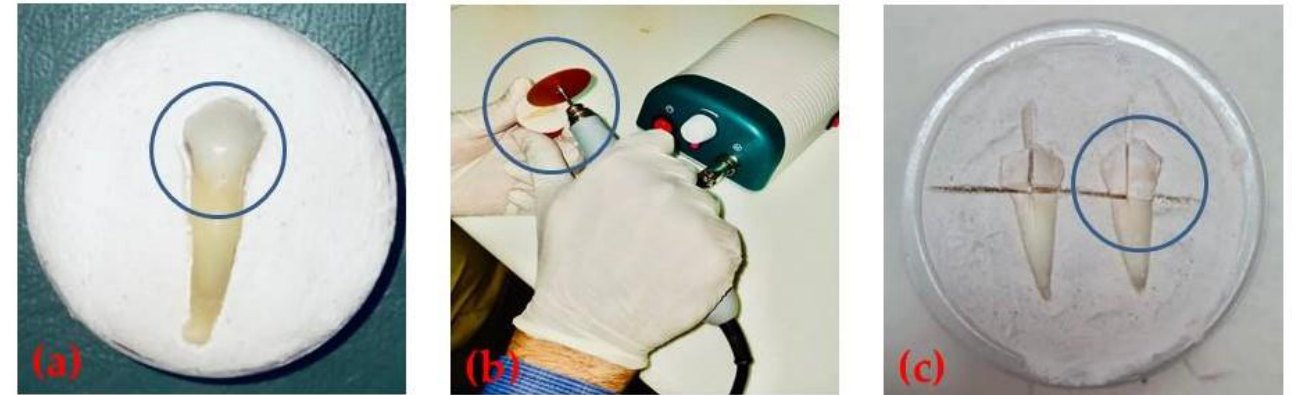
Figure 2. ( a ) Dried disinfected tooth. ( b ) Sectioning longitudinally using a microtome. ( c ) Cut into two longitudinal halves.